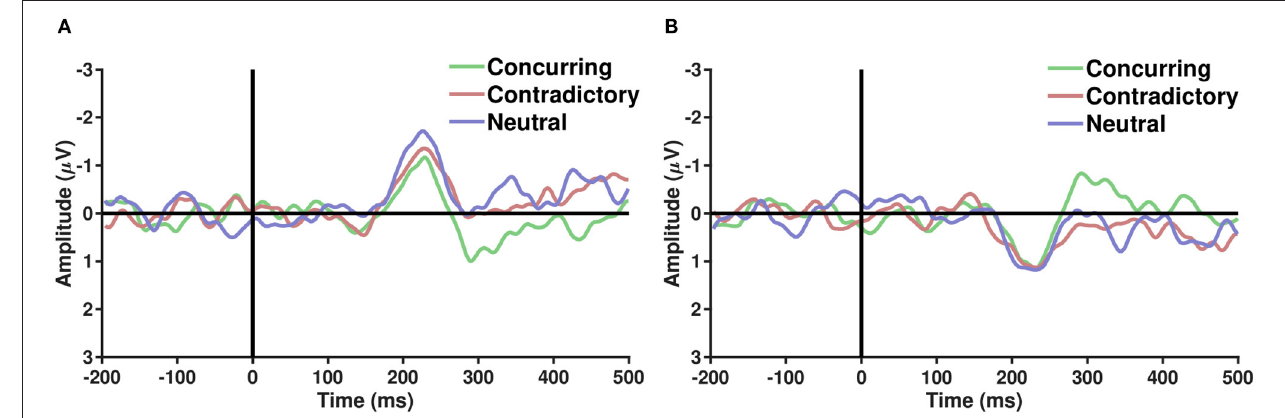
FIGURE 3 | (A,B) Show the grand average of difference ERPs (Face Car) over parieto occiptial and fronto central electrodes, respectively, across the three types of − conditions—Concurring, Conflicting, and Neutral. A sharp peak in the difference waveforms is observed post-200 ms across all conditions. Difference between conflicting and concurring cues seems more prominent around 250–300 ms.